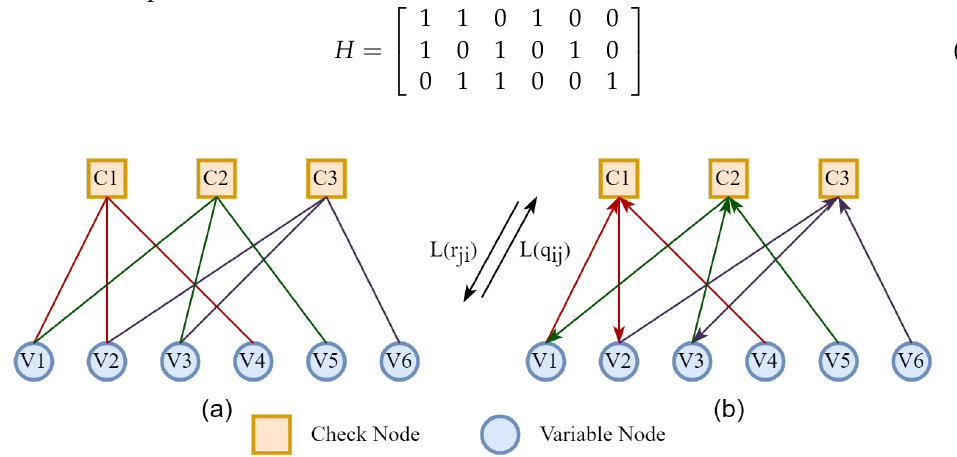
Figure 2. ( a ) The structure of the Tanner graph corresponds to Equation (2). ( b ) Node information transmitted in the Tanner graph. L ( r ji ) is the check node update information transmitted from the check node C j to the variable node V i . L ( q ij ) is the variable node update information transmitted from the variable node V i to the check node C j